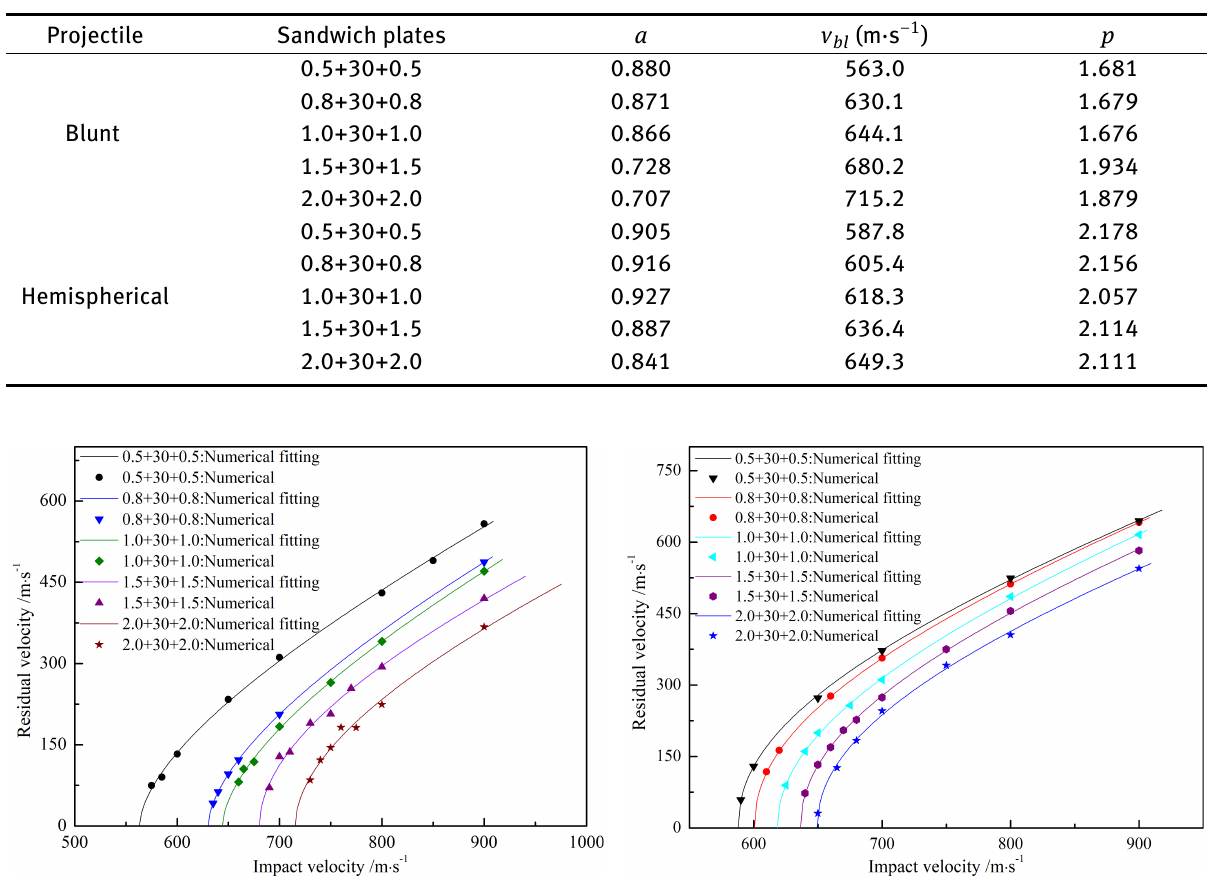
Figure 11: Residual velocity of steel/nylon sandwich plates versus impact velocity for different thicknesses of face-sheets